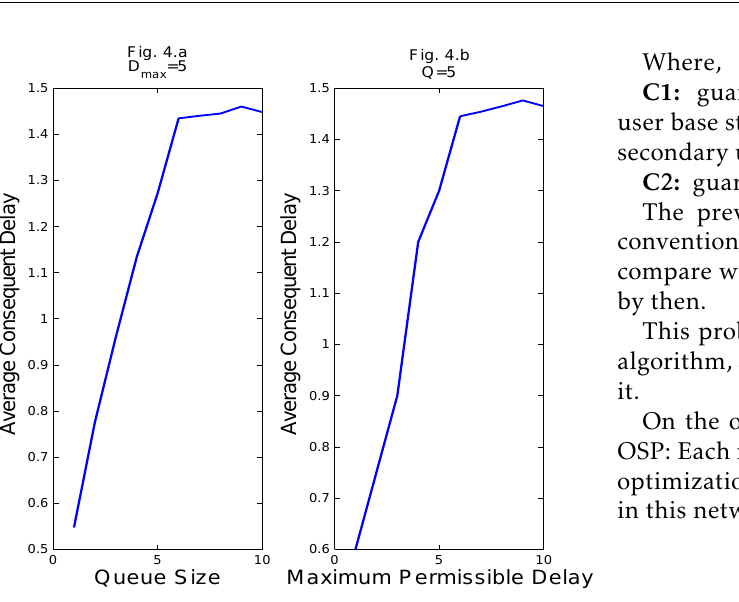
Figure 4. Effect of Queue Size and Maximum Permissible Delay Parameters on Average Consequent